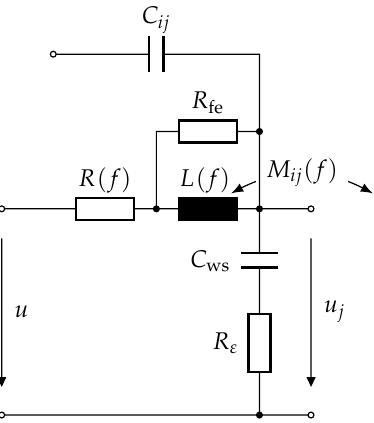
Figure 12. Single-turn model with frequency-dependent turn resistance R , self-inductance L , mutual inductance M , frequency-independent capacitance C and the additional loss elements R fe for iron losses and R ε for dielectric losses